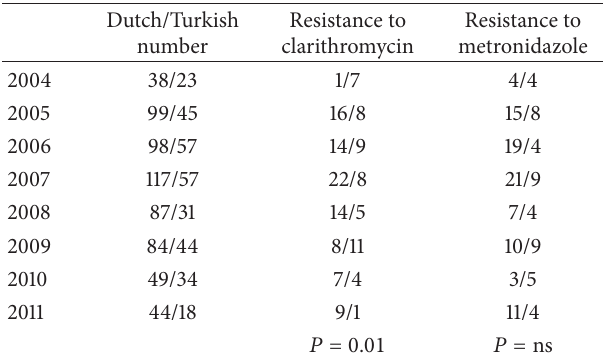
Table 3: Antimicrobial resistance in the eight consecutive years in Dutch patients and patients from Turkish descent.